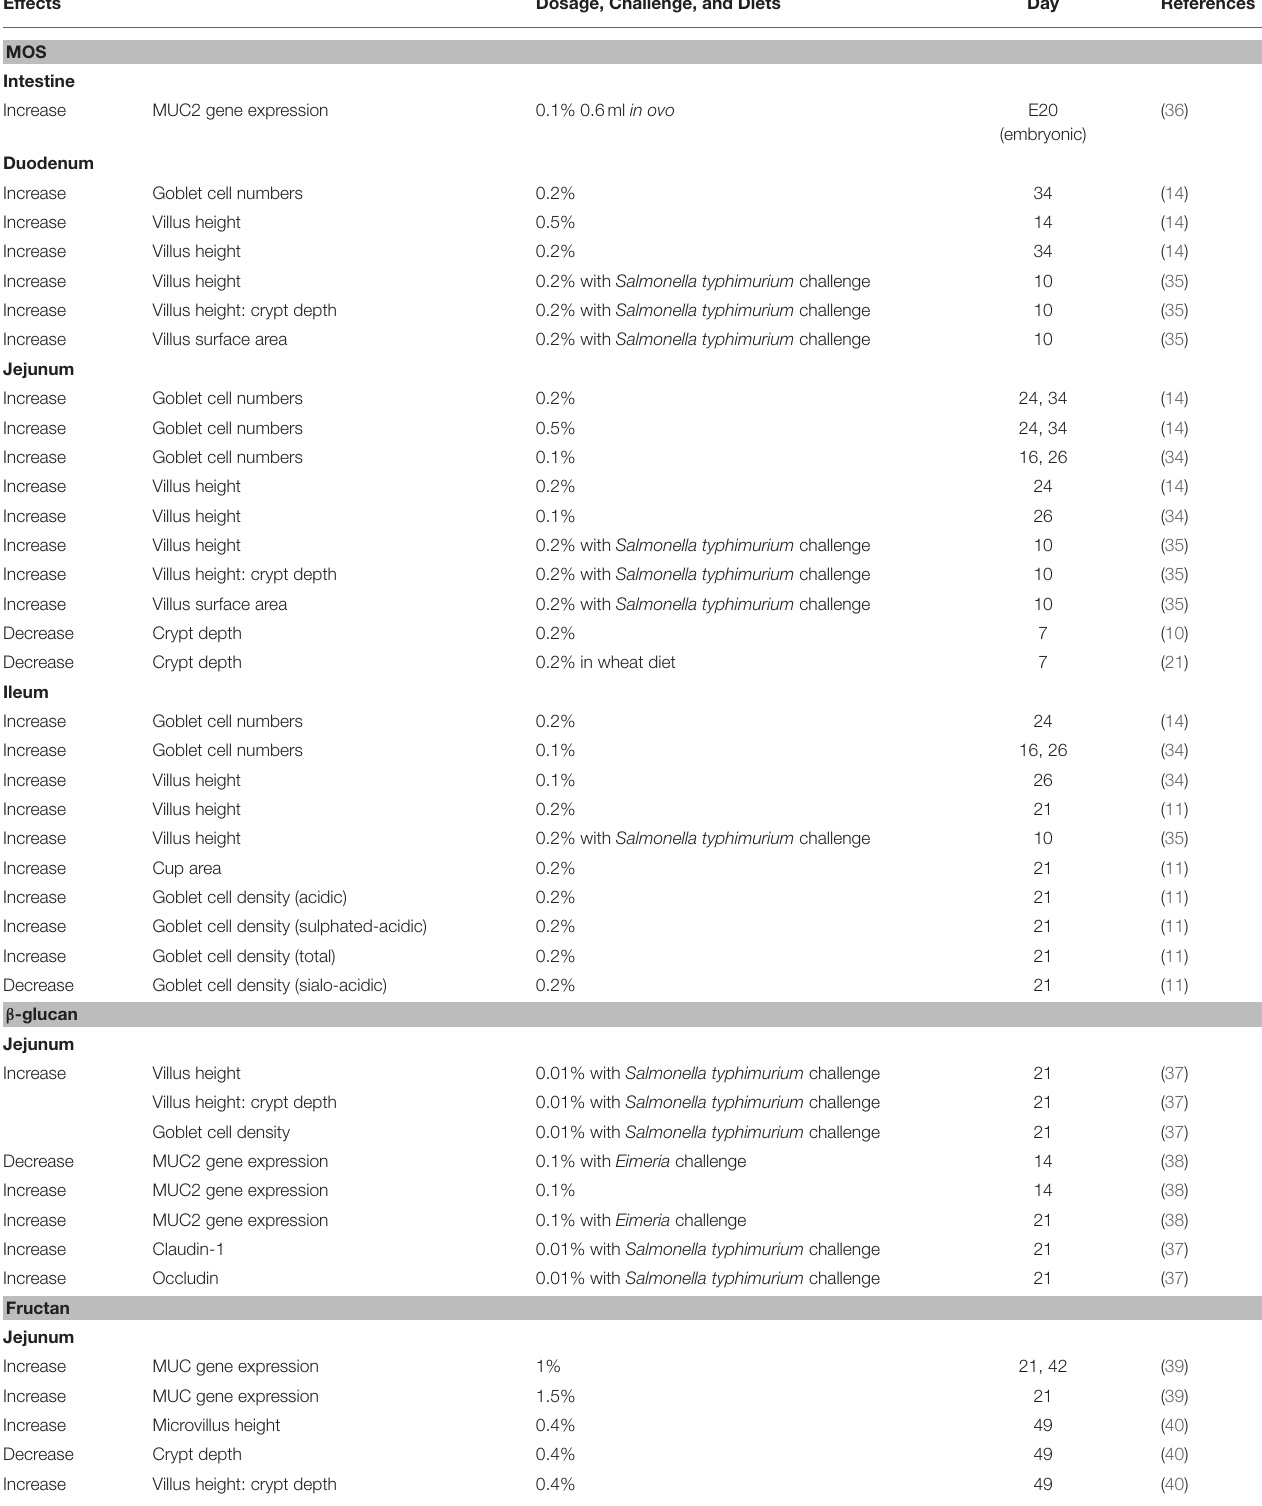
TABLE 2 | Effects of prebiotics on intestinal morphology of